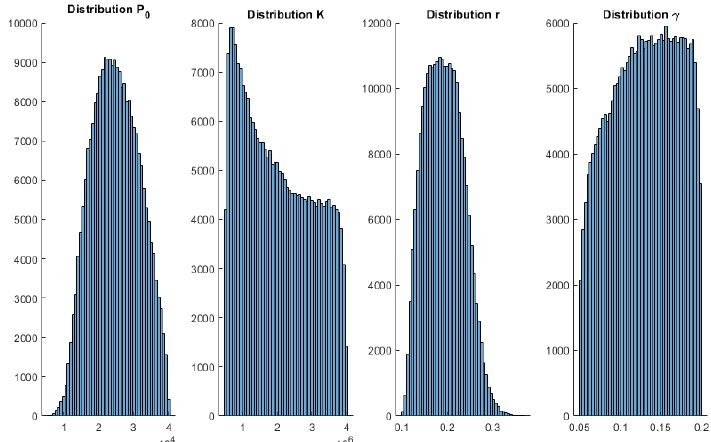
Figure A3. Histograms 5 January 2021 wave 3 SIR — Spain.